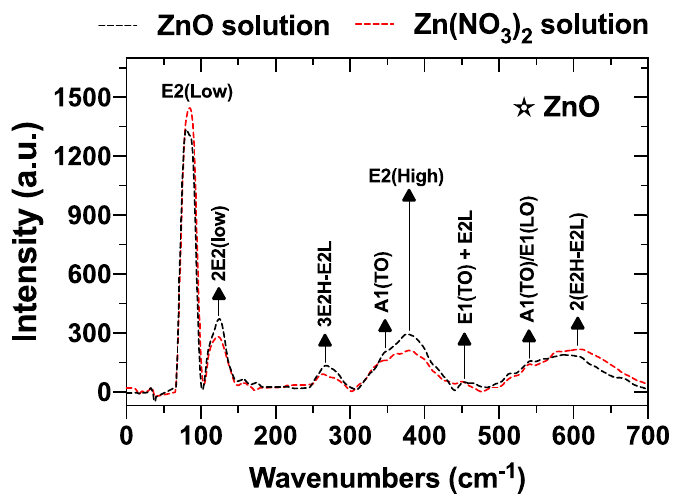
Figure 8. Raman spectra of electroless ZnO deposits on Mg-Ca0.3 surfaces, obtained as in Figure 7.